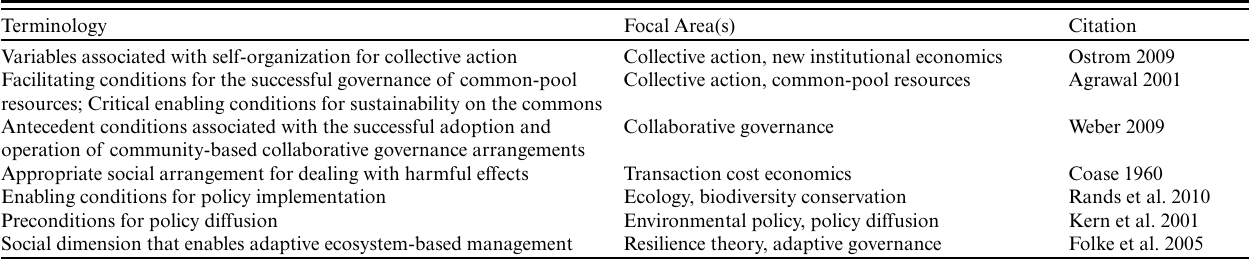
Table 1 . Examples of terms and concepts equivalent to “enabling condition” used in a range of disciplines and focal areas of